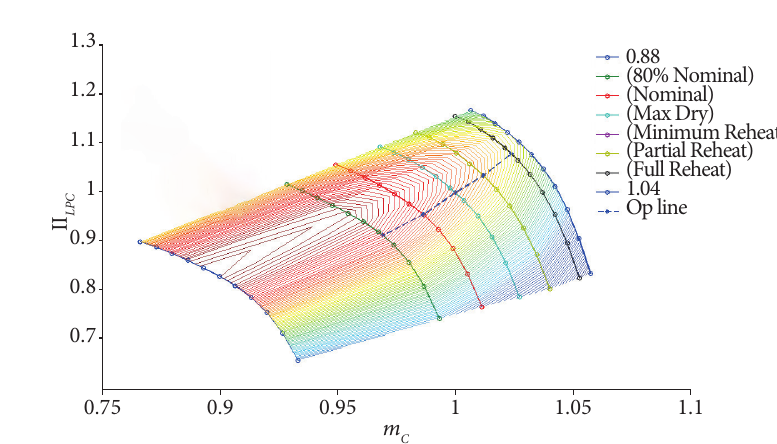
Figure 9. HPC map with experimentally obtained operating line after application scaling function on map. The figure shows that the experimental mass flow rate and the pressure ratio lie on the respective RPM lines of the characteristics